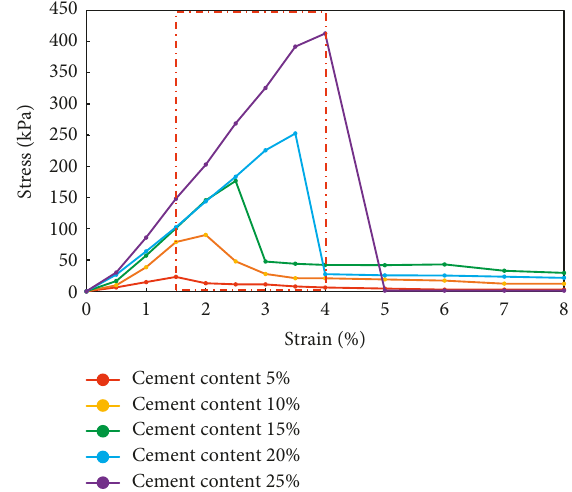
Figure 8: Stress-strain curve of cement soil cured for 90 days with different cement